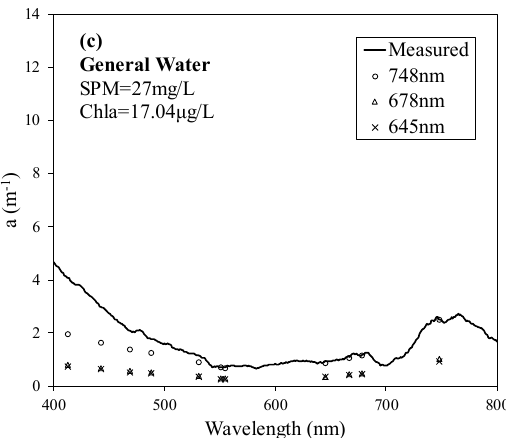
Figure 3. Comparison of measured total absorption coefficients with derived values of different reference wavelengths in ( a ) turbid, ( b ) eutrophic, and ( c ) general water.